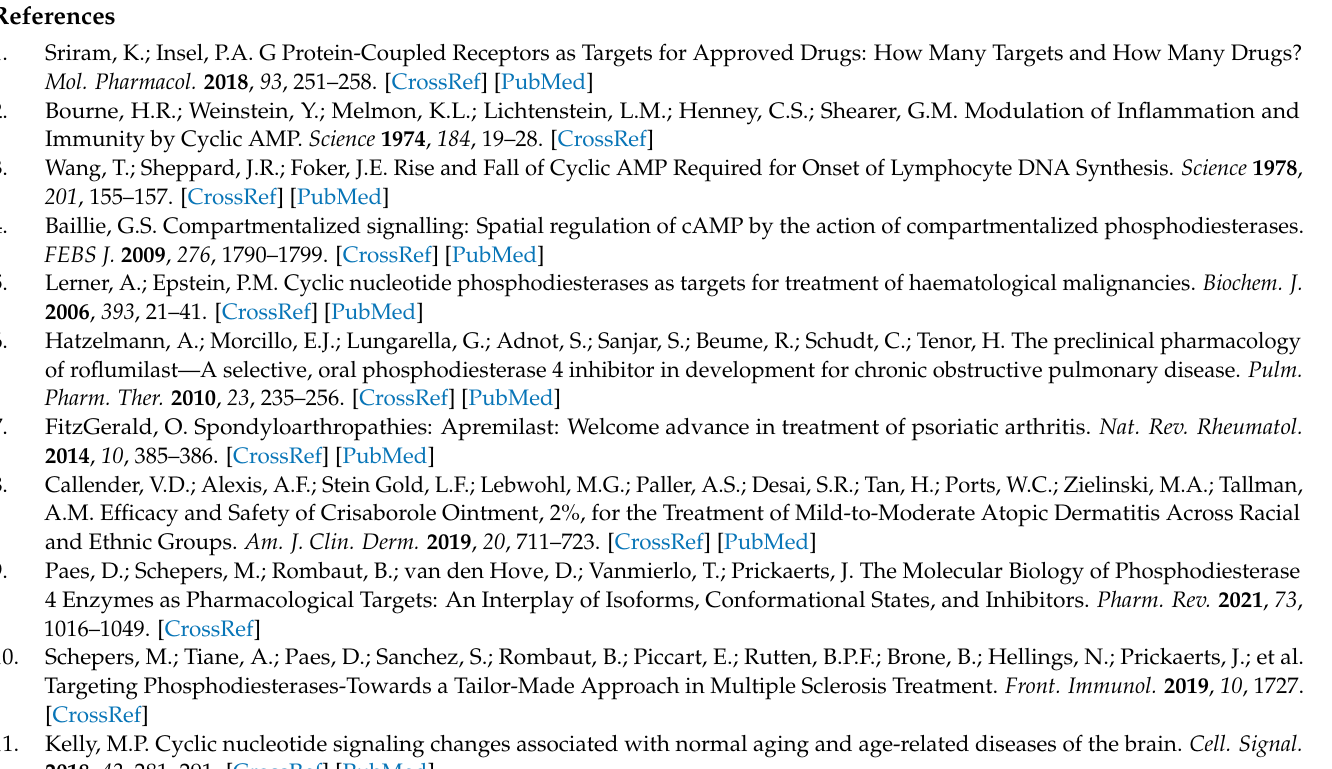
Figure S3: Treatment with the PF-04957325 does not affect pro-inflammatory cytokine production in the spleen; Figure S4: Treatment with the PF-04957325 does not affect anti-inflammatory cytokine production in the cervical lymph nodes and